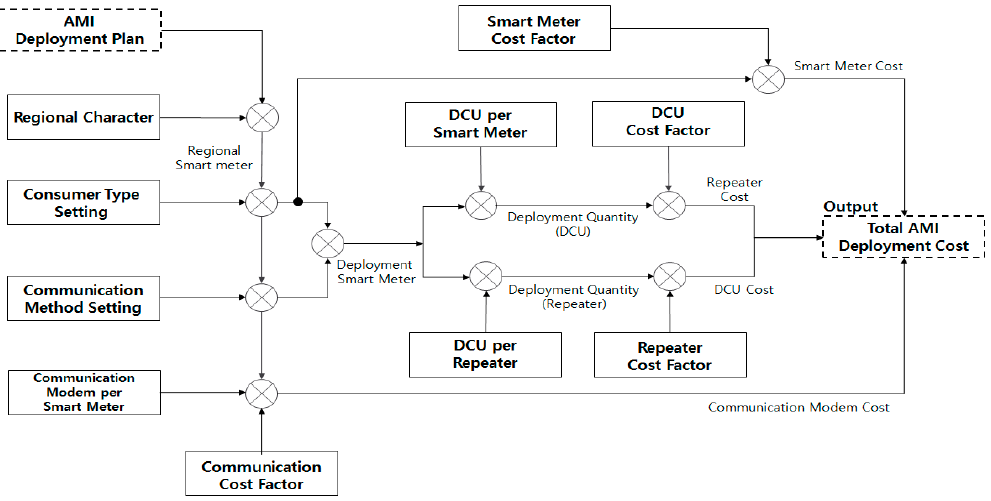
Figure 2. Hybrid AMI System Model.